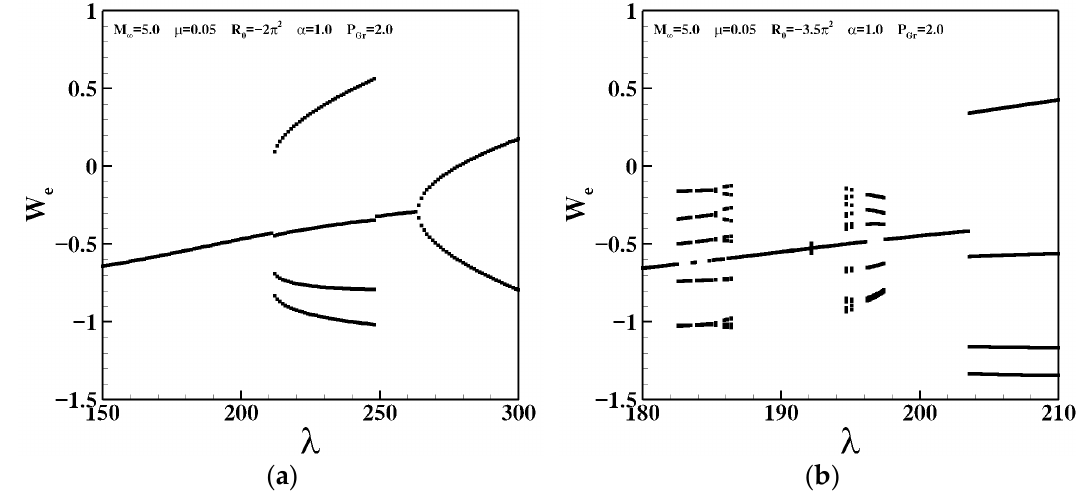
Figure 6. Multiple bifurcations: ( a ) R 0 = − 2 π 2 ; ( b ) R 0 = − 3.5 π 2 . Figure 7 shows the time history and phase diagram of the panel de- formation when